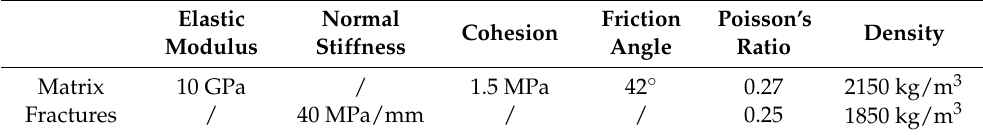
Table 8. Material parameters of the rock matrix and fractures.